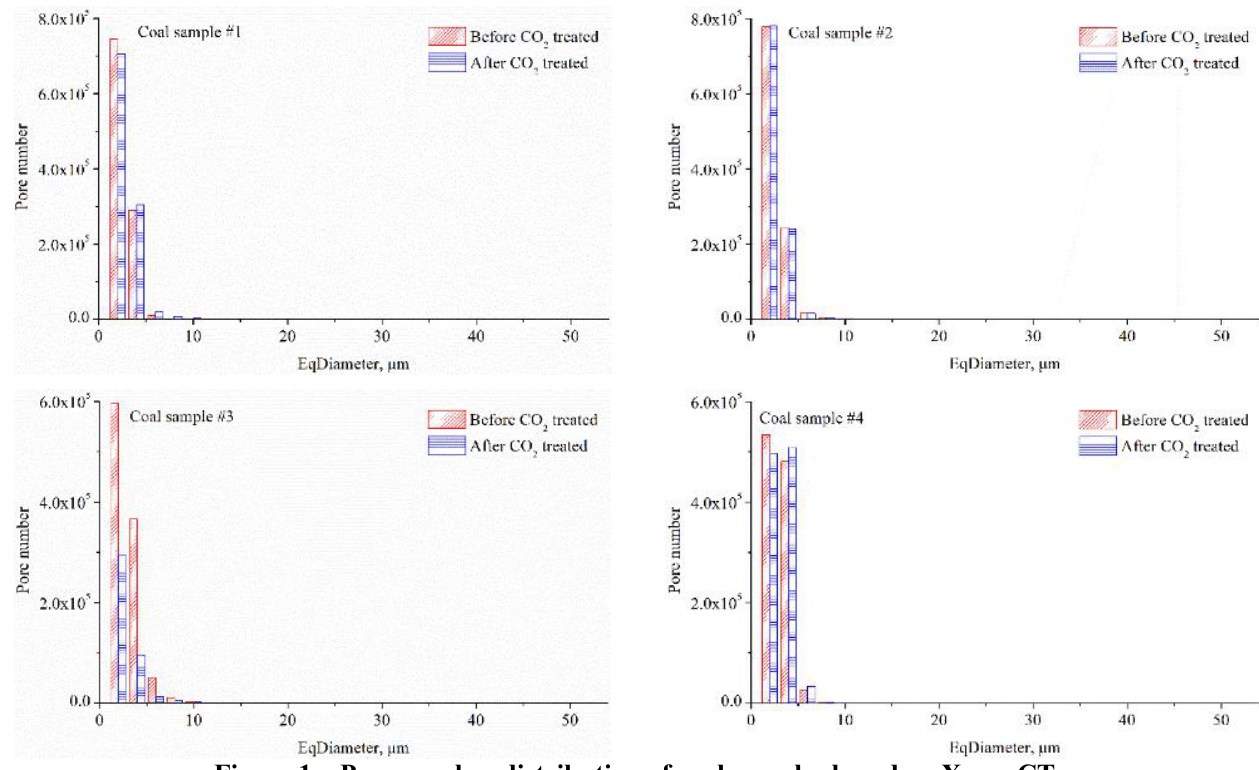
Figure 1—Pore number distribution of coal samples based on X-ray CT.